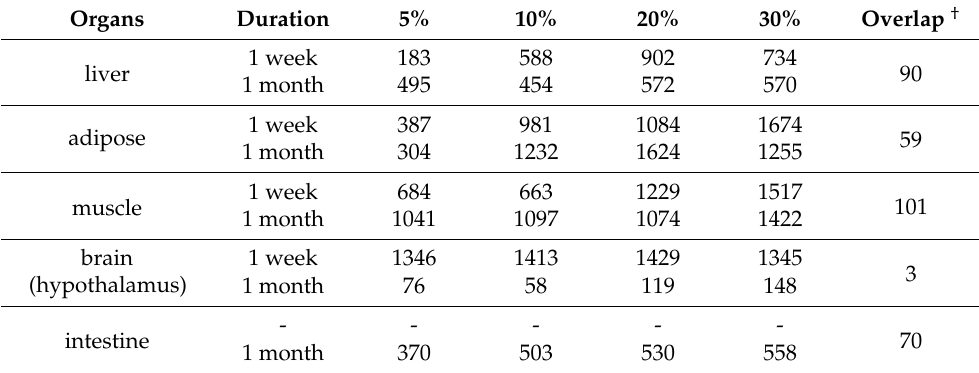
Table 1. Number of genes altered by short-term and mild-to-moderate